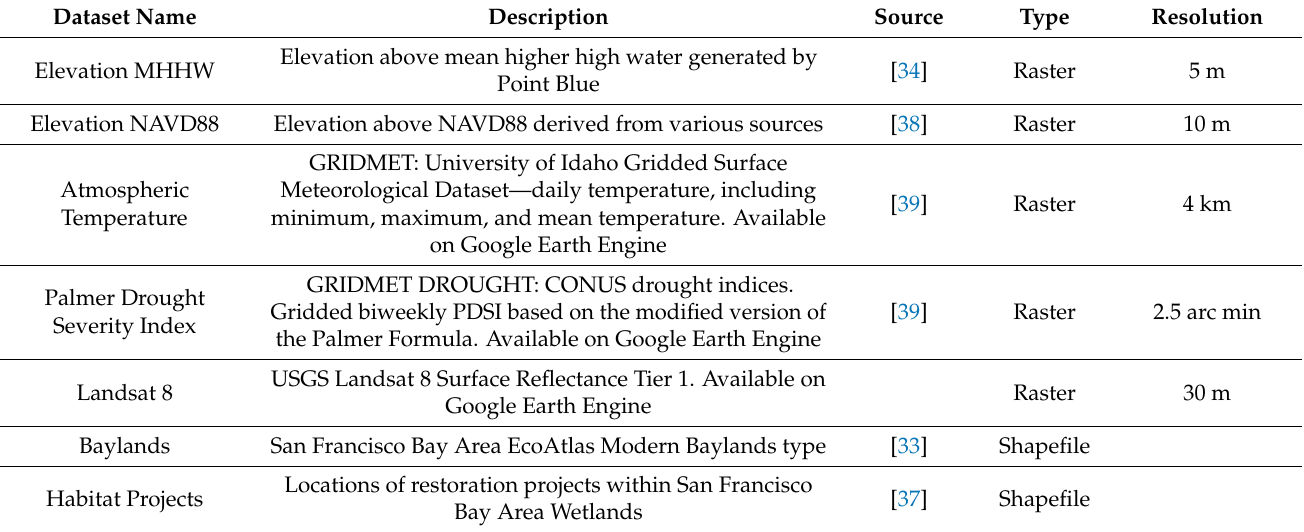
Table 1. Datasets used to build the models and to further analyze model